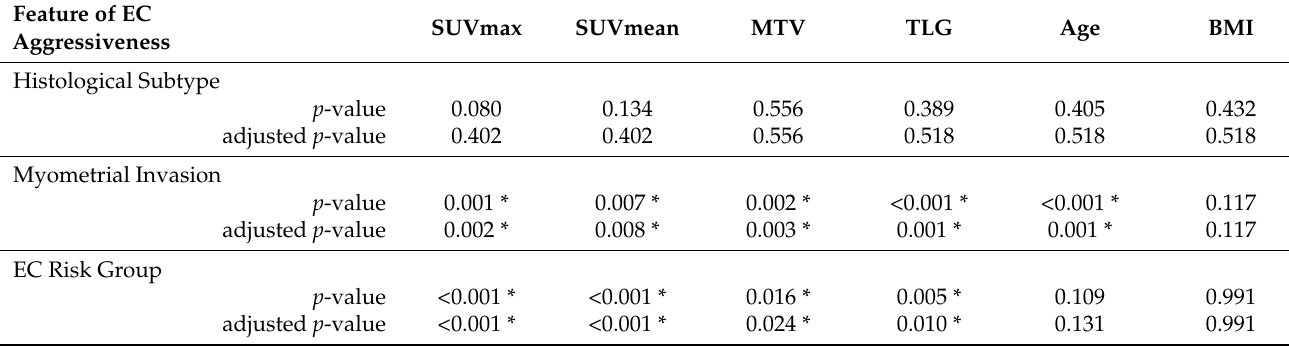
Table 2. Comparison of the distribution of 18 F-FDG PET and clinical parameters between the groups defined by the different features of EC